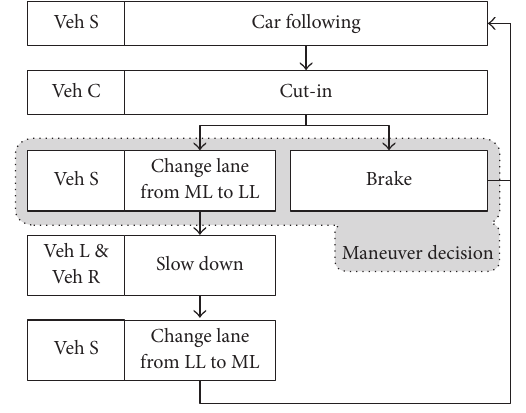
Figure 2: Experiment